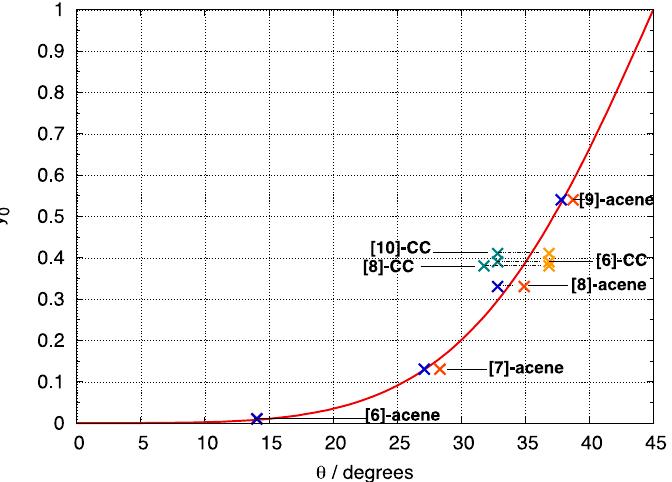
Figure 4. Dependence of the di-radical character y 0 (PUB3LYP) as a function of BS orbital rotation angle θ . Analytic expression from Equation (5) (red curve); θ determined for the HOMO BS orbitals (orange crosses for [n]-acenes , gold crosses for [n]-CCs ); θ determined for the LUMO BS orbitals (blue crosses for [n]-acenes , green crosses for [n]-CCs ).